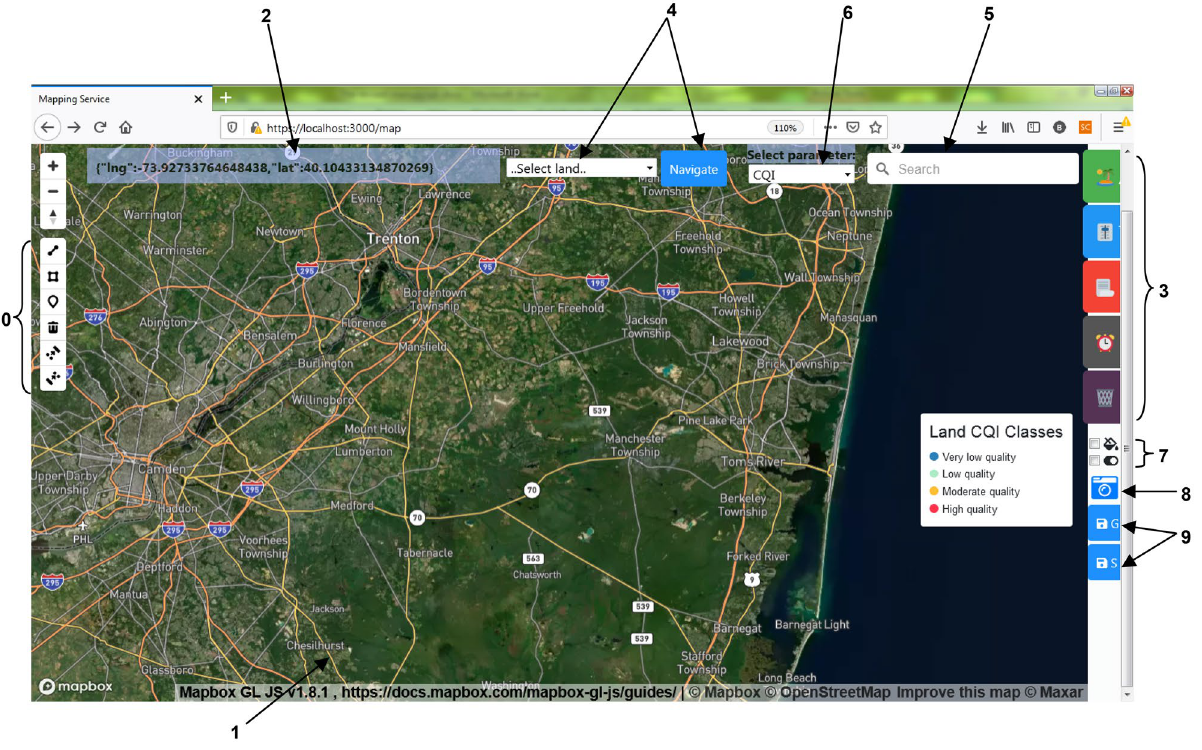
Figure 11. The mapping service main